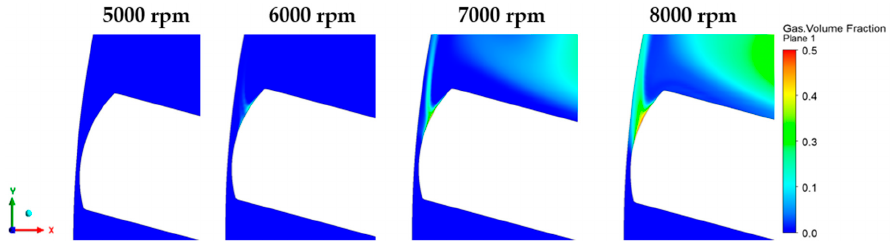
Figure 19. Development of the vapor gas volume fraction distribution focusing on radial gap 1 at 5-bar delivery pressure for different rotational speeds.